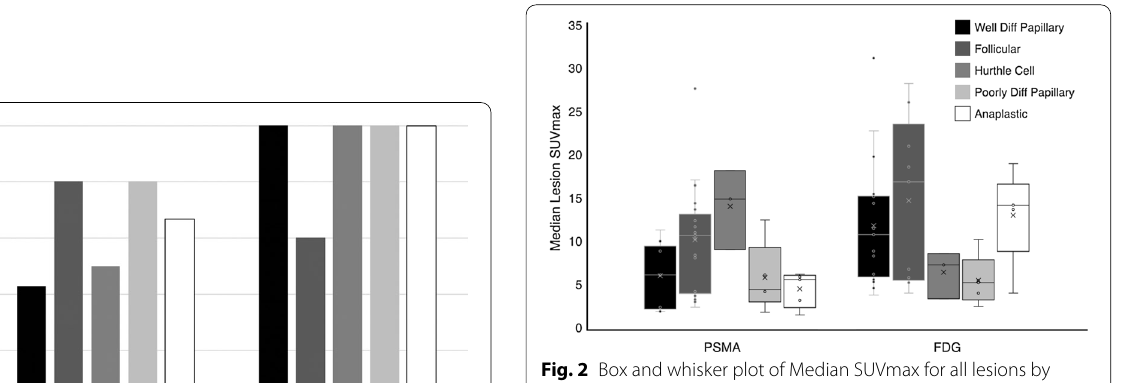
Soft tissues are subdivided into lungs (most common) and “other.” “Other” locations consisted of: scalp, dura, adrenal, paraspinous tissues, and pancreas